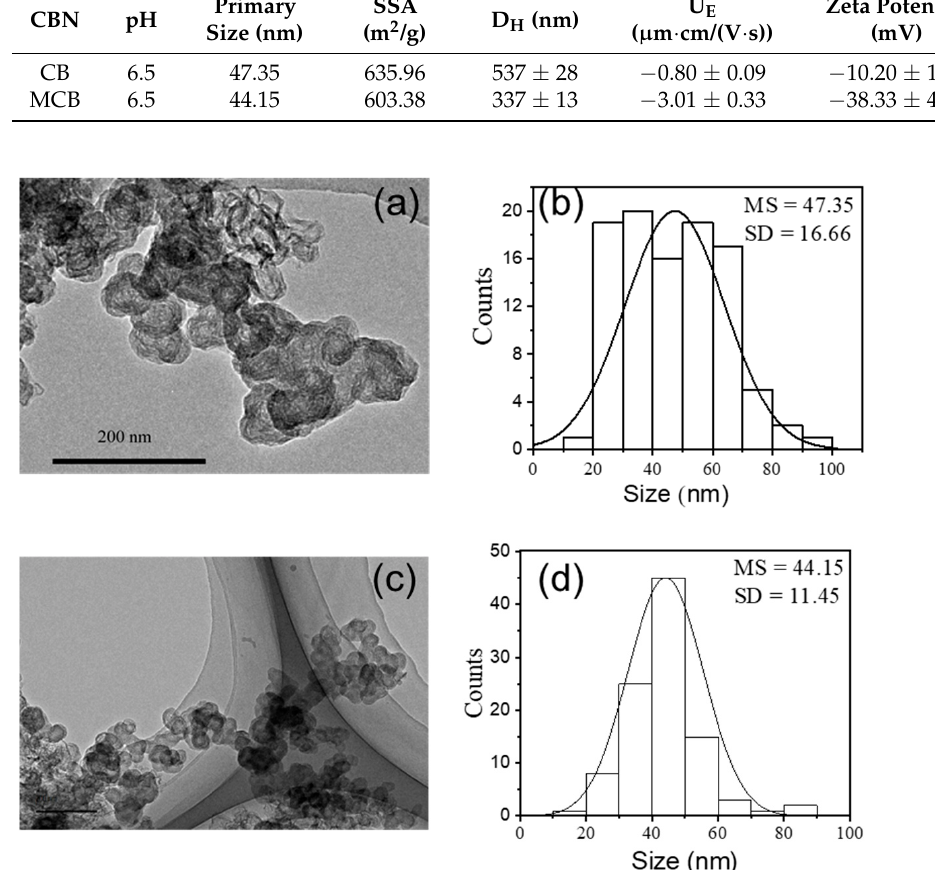
Figure 3. TEM images ( a , c ), and histogram and Gaussian fit of the size distribution ( b , d ) of CB ( a , b ) and MCB ( c , d ) particles. MS indicates the mean size and SD means the standard deviation (n = 100).